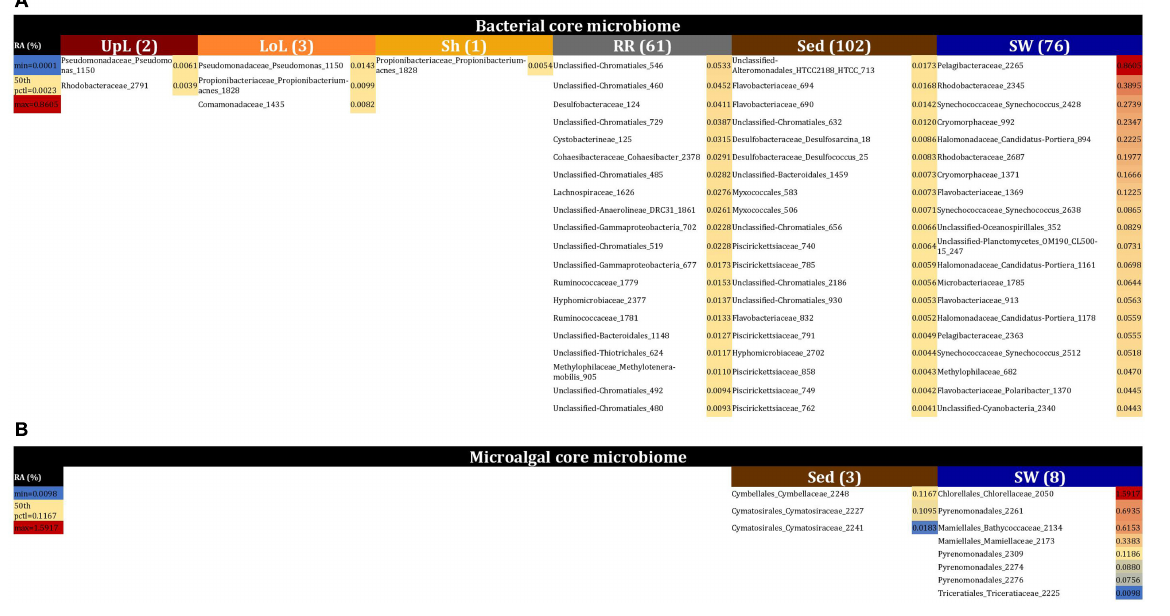
Frontiers in Microbiology |